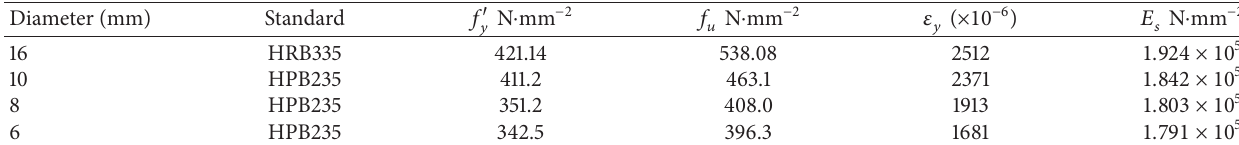
Table 1: Mechanical properties of steel.